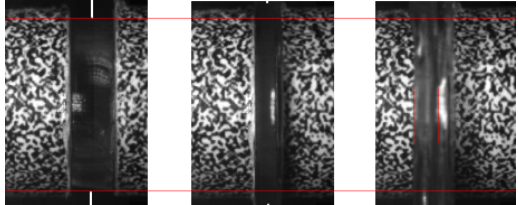
Figure 10. Comparison of intact and deformed state of ordnance gelatin specimen. Middle: white bars highlight the radial expansion. Right: Overlap of the gelatin over the transmission bar highlighted by red